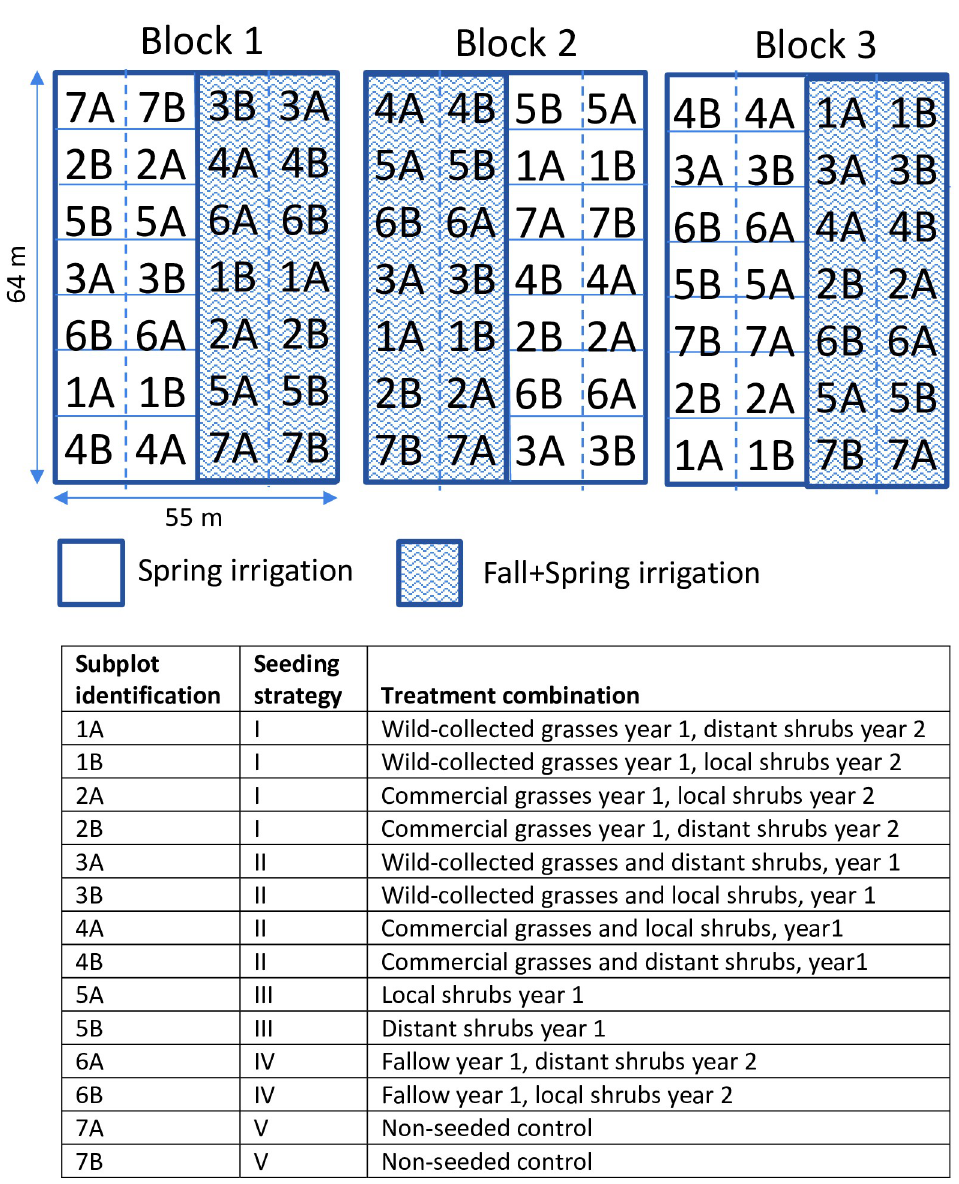
Fig 2. Actual experimental layout schematic at the South Field, illustrating the experimental design used in this study. Half of each block (a 64 m x 27.4 m sub-block) received the same irrigation treatment. Within each sub-block, 7 plots (e.g., 1A and 1B together) were randomly arranged. Plots were then divided into subplots (e.g., 1A, 1B), each randomly assigned with a different origin of shrub seed (local or distant), except for plot 7 which was unseeded (see table above, which identifies each subplot treatment and the corresponding seeding strategy). Though it was unseeded, Plot 7 was also divided into subplots to keep sampling effort consistent among treatments. See Methods for details.